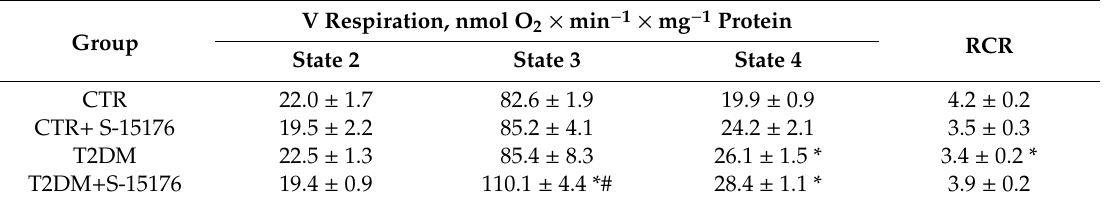
Table 3. The respiration rates of mouse liver mitochondria of the experimental